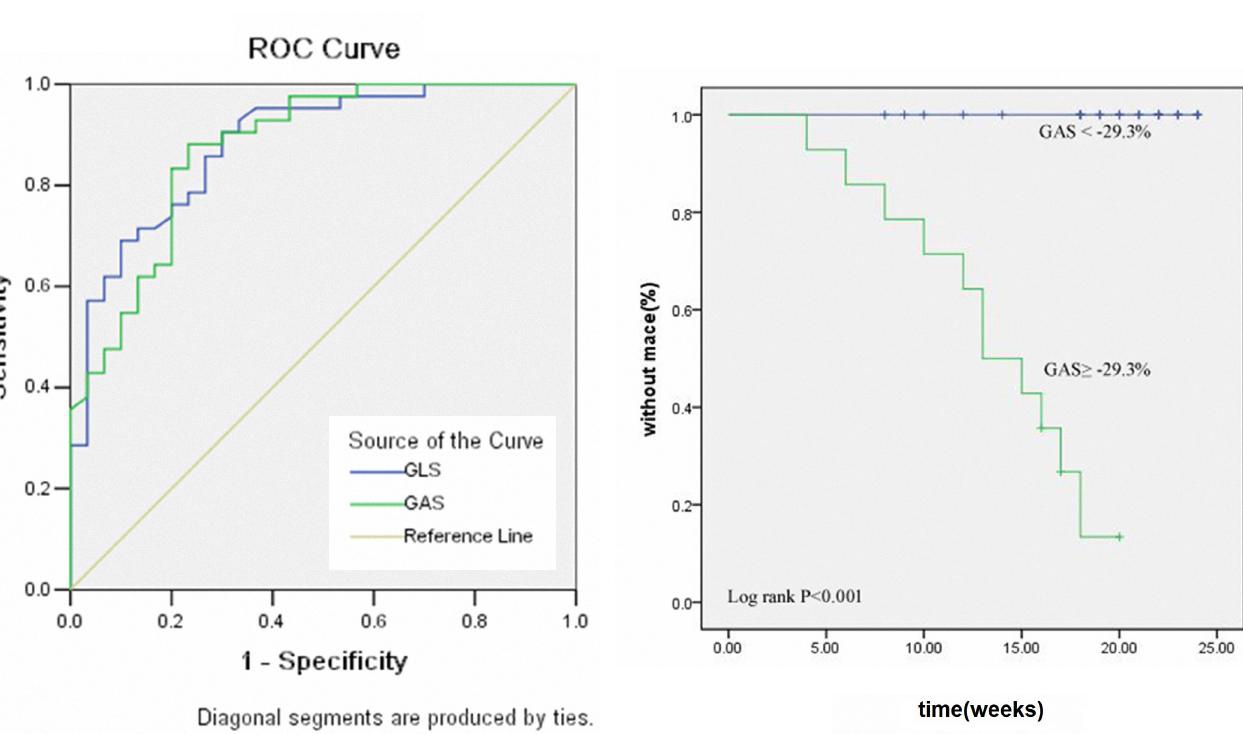
Fig. 3 – Survival analysis according to global area strain (GAS) markers. There were significant differences between the GAS < -29.3% group and the GAS